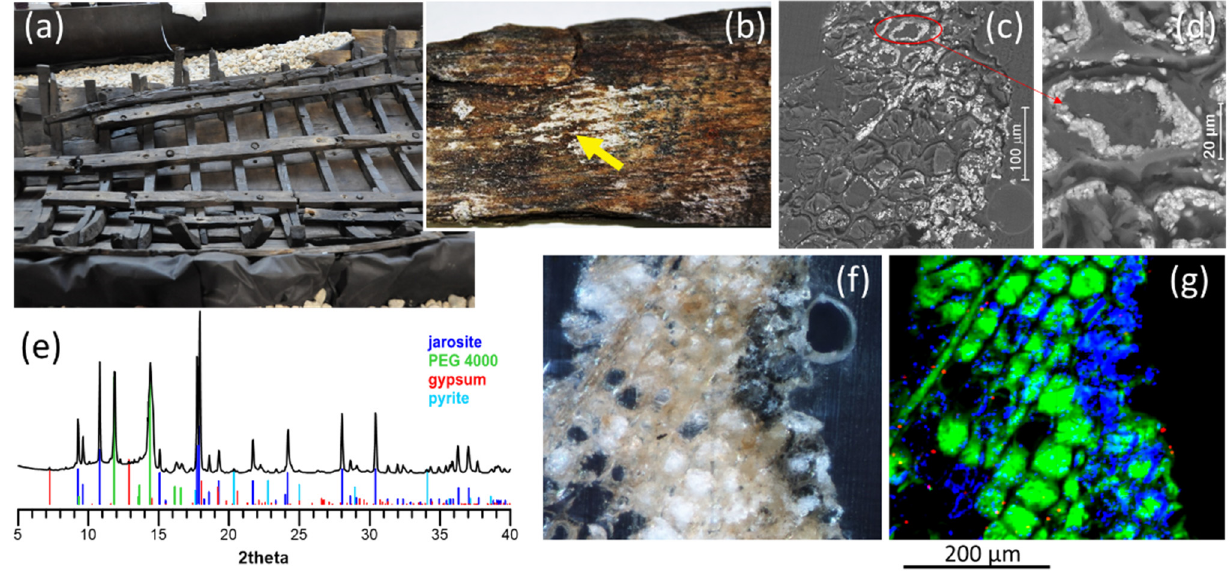
Figure 7. Study of the degradation of a waterlogged medieval timber hull. ( a ) View of the vessel Sorres X (Museu Marítim de Barcelona), which has a total length of 9.5–10 m. ( b ) Detail of efflorescence on pine wood. Back-scattering SEM images of ( c ) a thin cross section of the same pine wood sample and ( d ) detail showing crystal accumulations on the inner side of the cell wall. ( e ) Average diffractogram of a transversal 20 µm-microtomed section of the same pine wood sample, compared to reference patterns and ( f ) corresponding microscopic image and ( g ) False-color µXRPD map, where the inner part of the wood is on the left and the wood surface is on the right of the images. Colors in the µXRPD map represent PEG (green), jarosite (blue) and gypsum (red); 456 × 386 µm 2 map, obtained with a 2.5 × 2.5 µm 2 beam, with a step of 1 × 1 µm 2 .